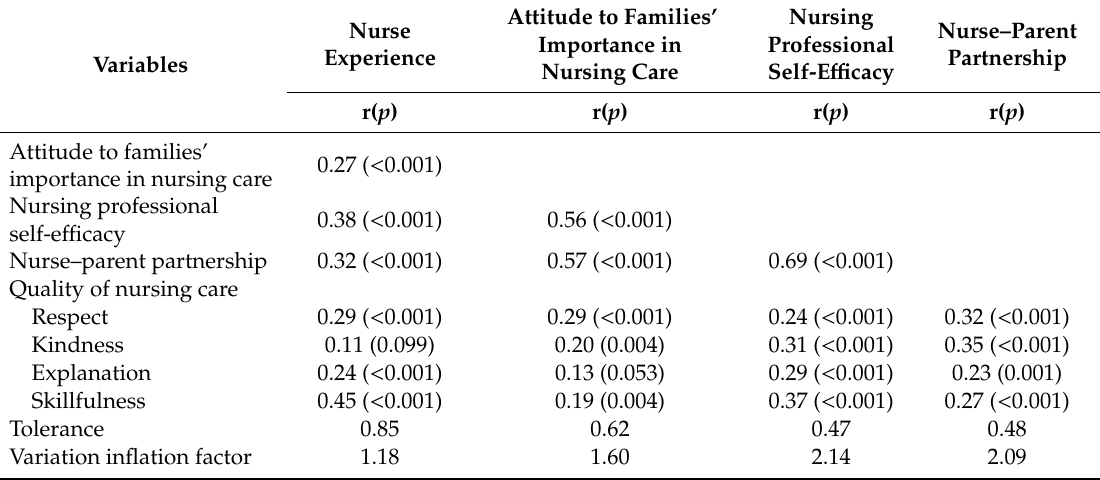
Table 2. Correlation, tolerance, and variation inflation factor among the measured variables ( N = 218).